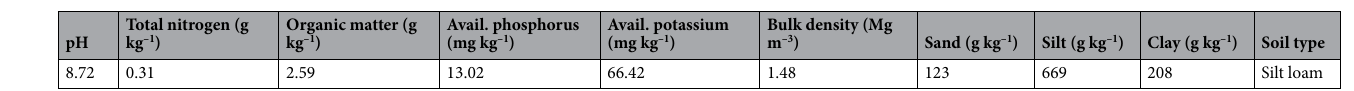
Table 1. Basic chemical and physical properties of the soil (0–20 cm) in 2014 at the experimental field site.